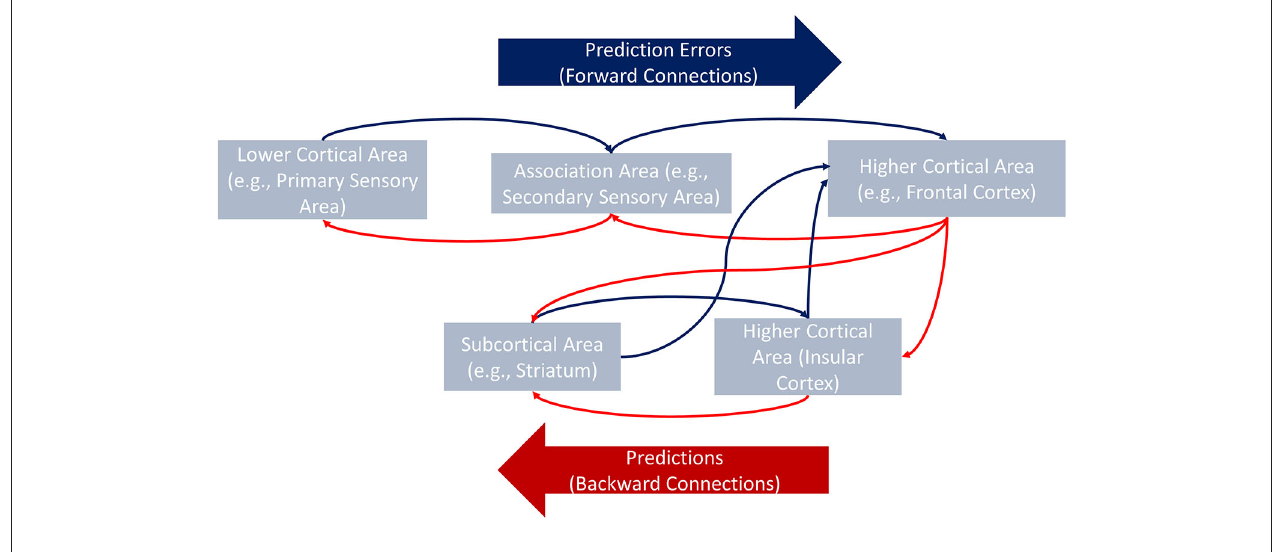
intrinsic interactions minimize the difference between the expected and the actual information (i.e., PE). When PEs are not minimized at a given level (e.g., in the striatum), they are passed along to the next level (e.g., the IC) which receives new predictions from the top of the hierarchy (the frontal cortex). The process continues upstream until the PEs are completely